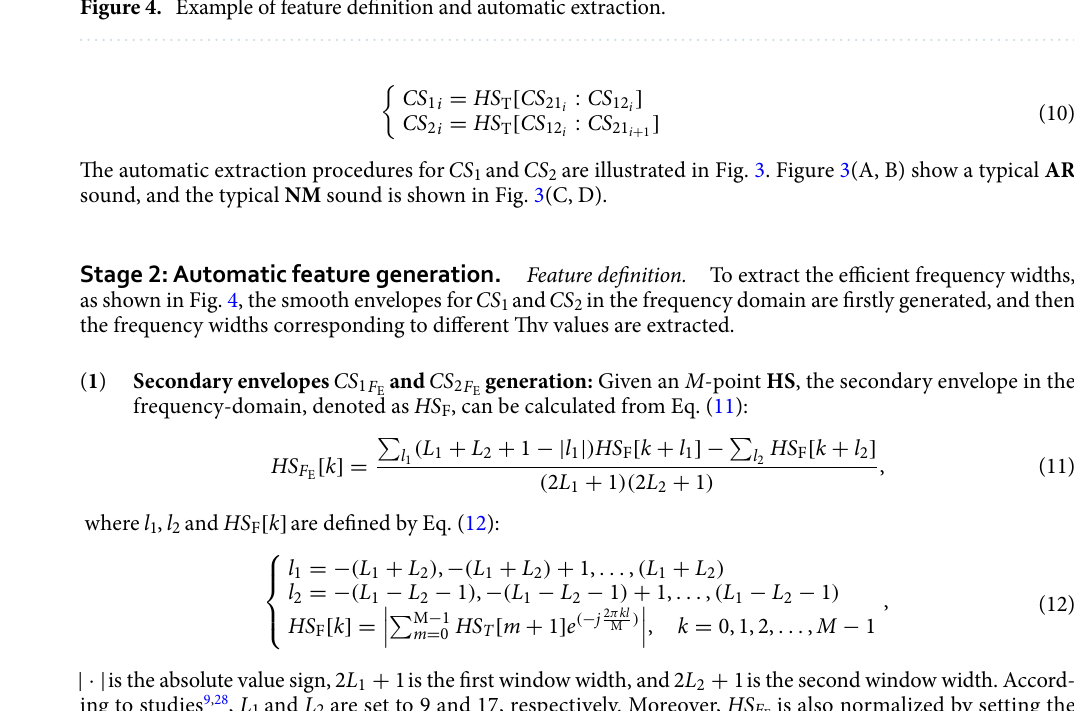
Figure 4. Example of feature definition and automatic